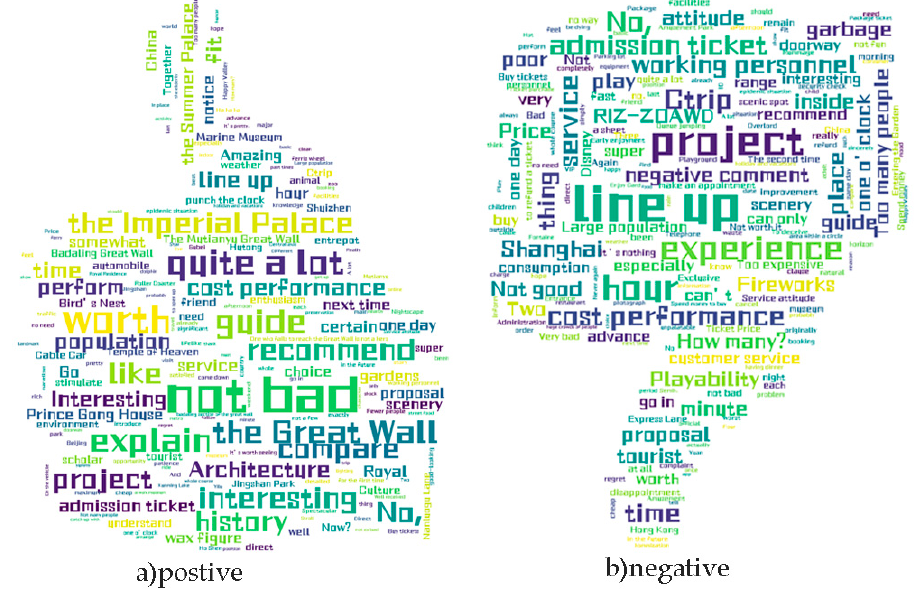
Figure 8. Word cloud display of positive and negative evaluations. Word clouds were created using the positive and negative reviews in the dataset to obtain the two highest rated word frequency images.